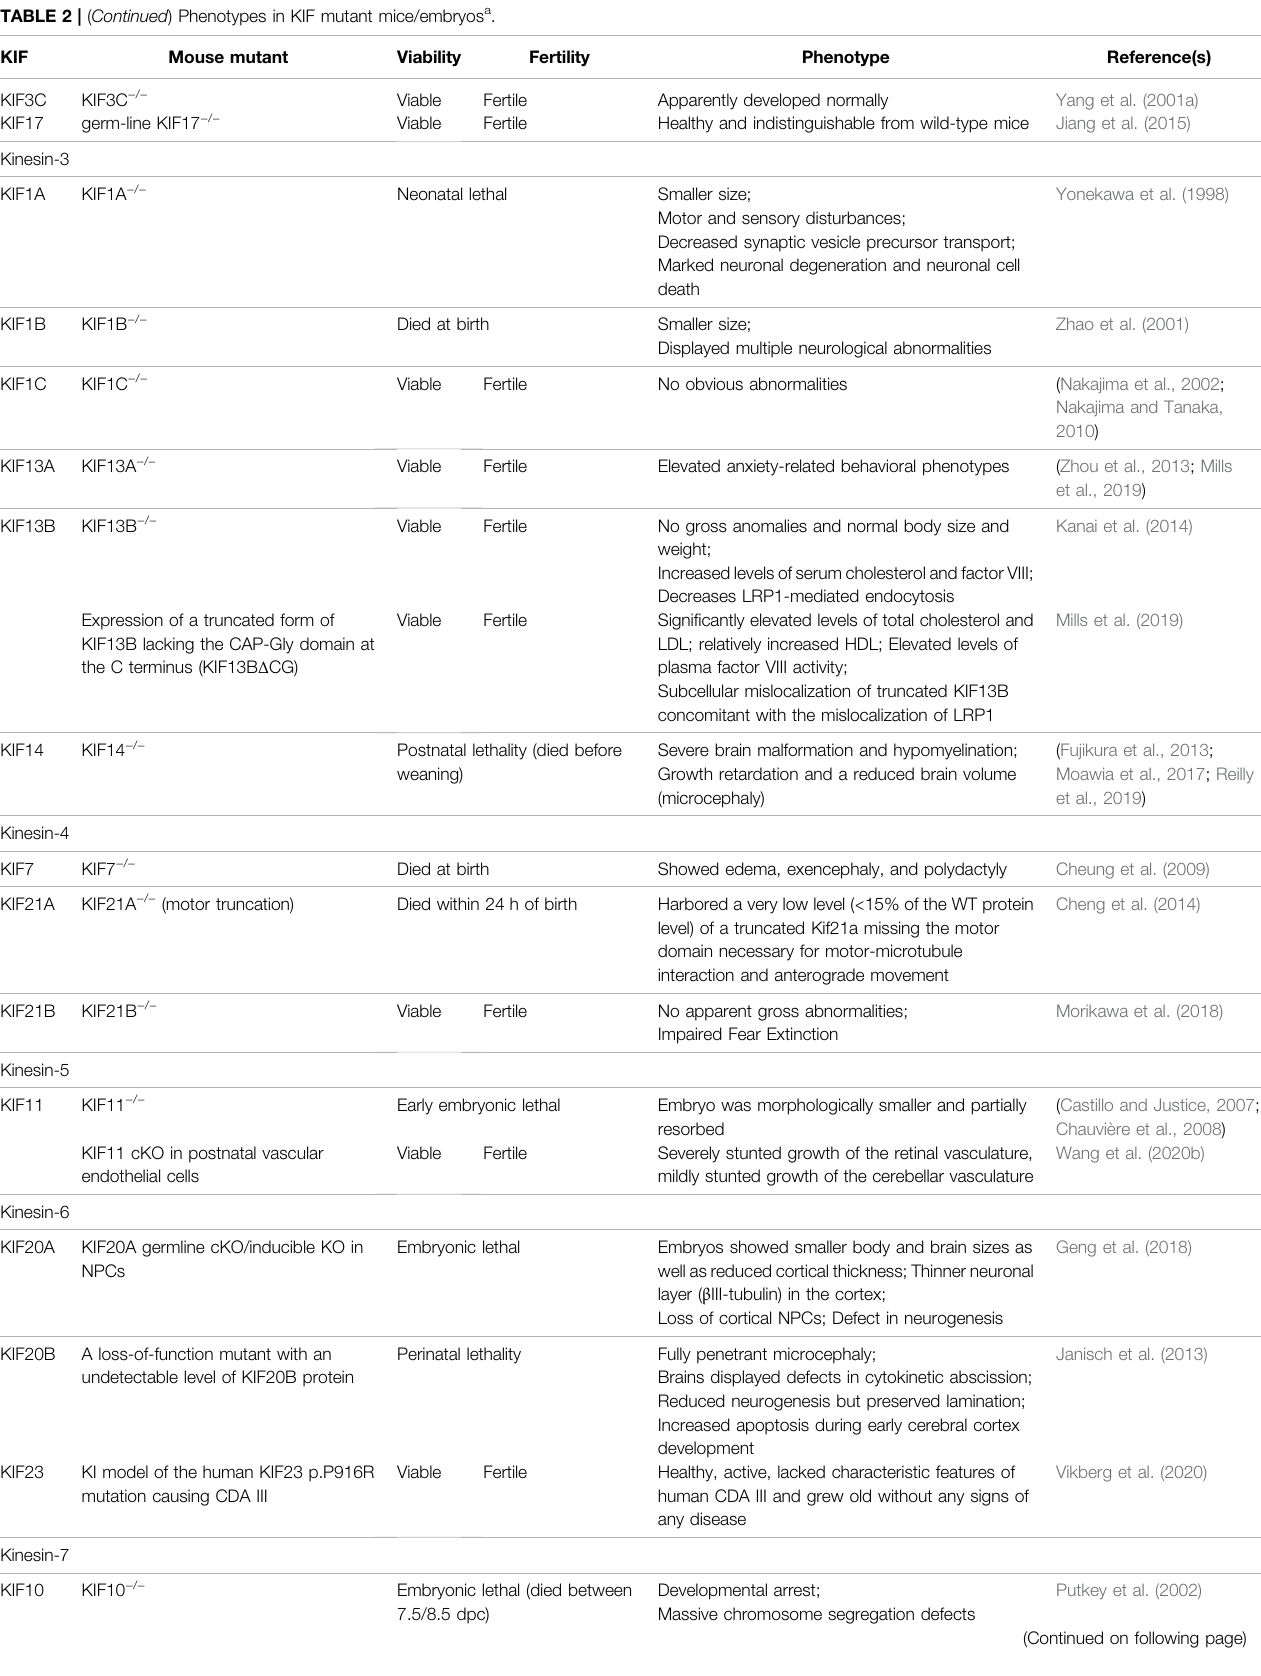
TABLE 2 | ( Continued ) Phenotypes in KIF mutant mice/embryos a